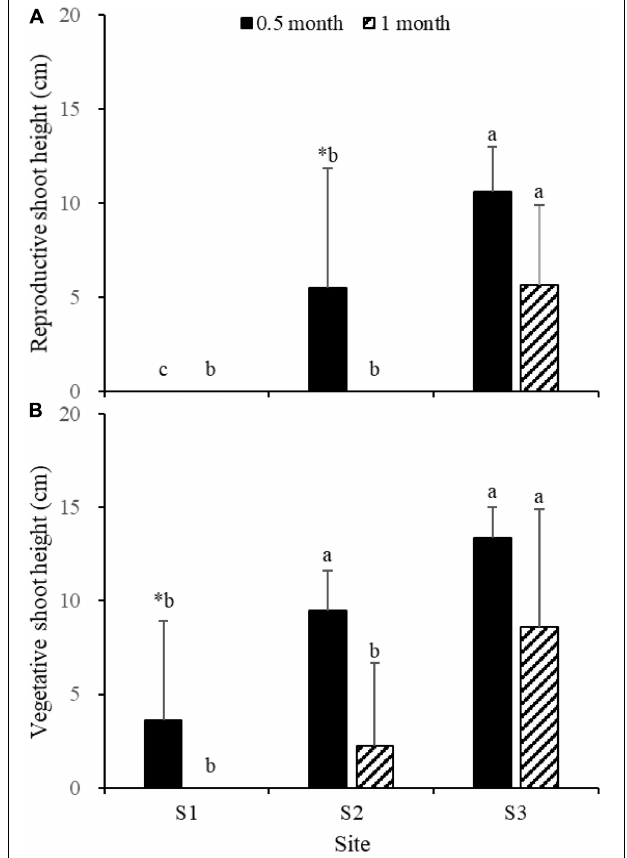
FIGURE 10 | Reproductive shoot height (A) and vegetative shoot height (B) of Zostera japonica in the three transplant sites at 0.5 and 1 month after transplantation. Values are mean ± SD. ∗ Indicates significant difference between time points in the same transplant site. Different letters indicate significant difference between different transplant sites at the same time